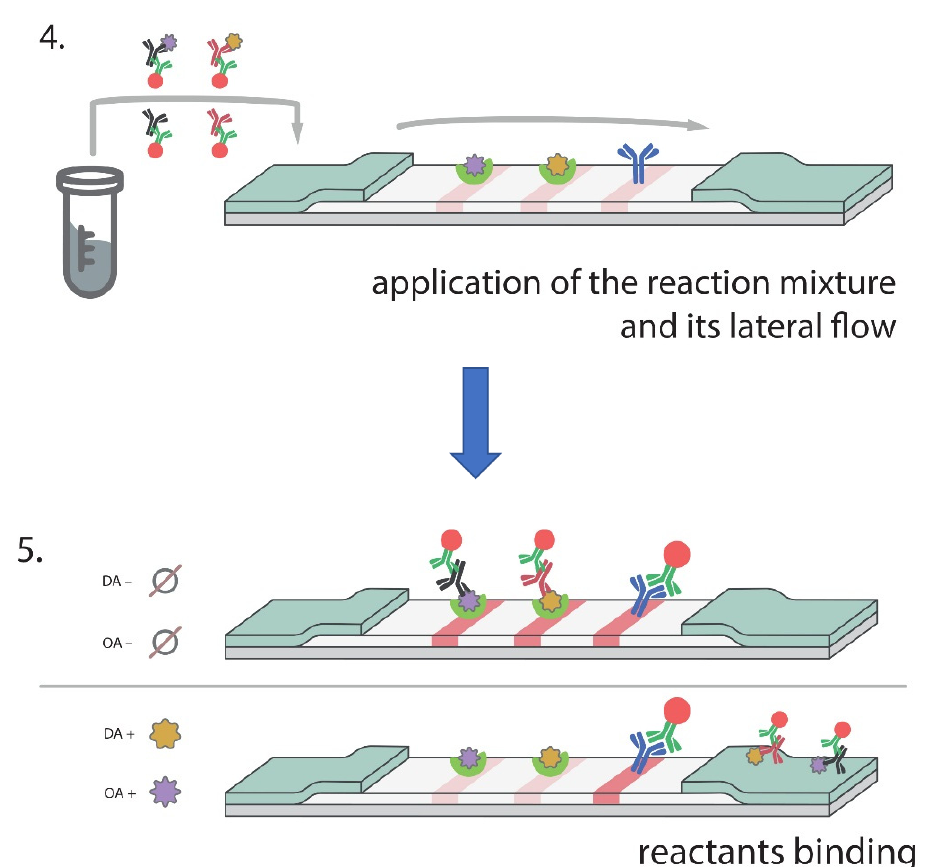
Figure 5. Flow chart for the developed double ICA of DA and OA. 1: test strips for the double ICA of DA and OA are obtained; 2: reaction mixtures containing a tested sample, anti-DA, anti-OA specific MAbs, and GAMI–AuNPs are prepared; 3: immune interactions occur in the reaction mixtures; 4: test strips are immersed in the reaction mixtures; 5: liquid flow moves along the test strip followed by the immune interactions on the working membrane.